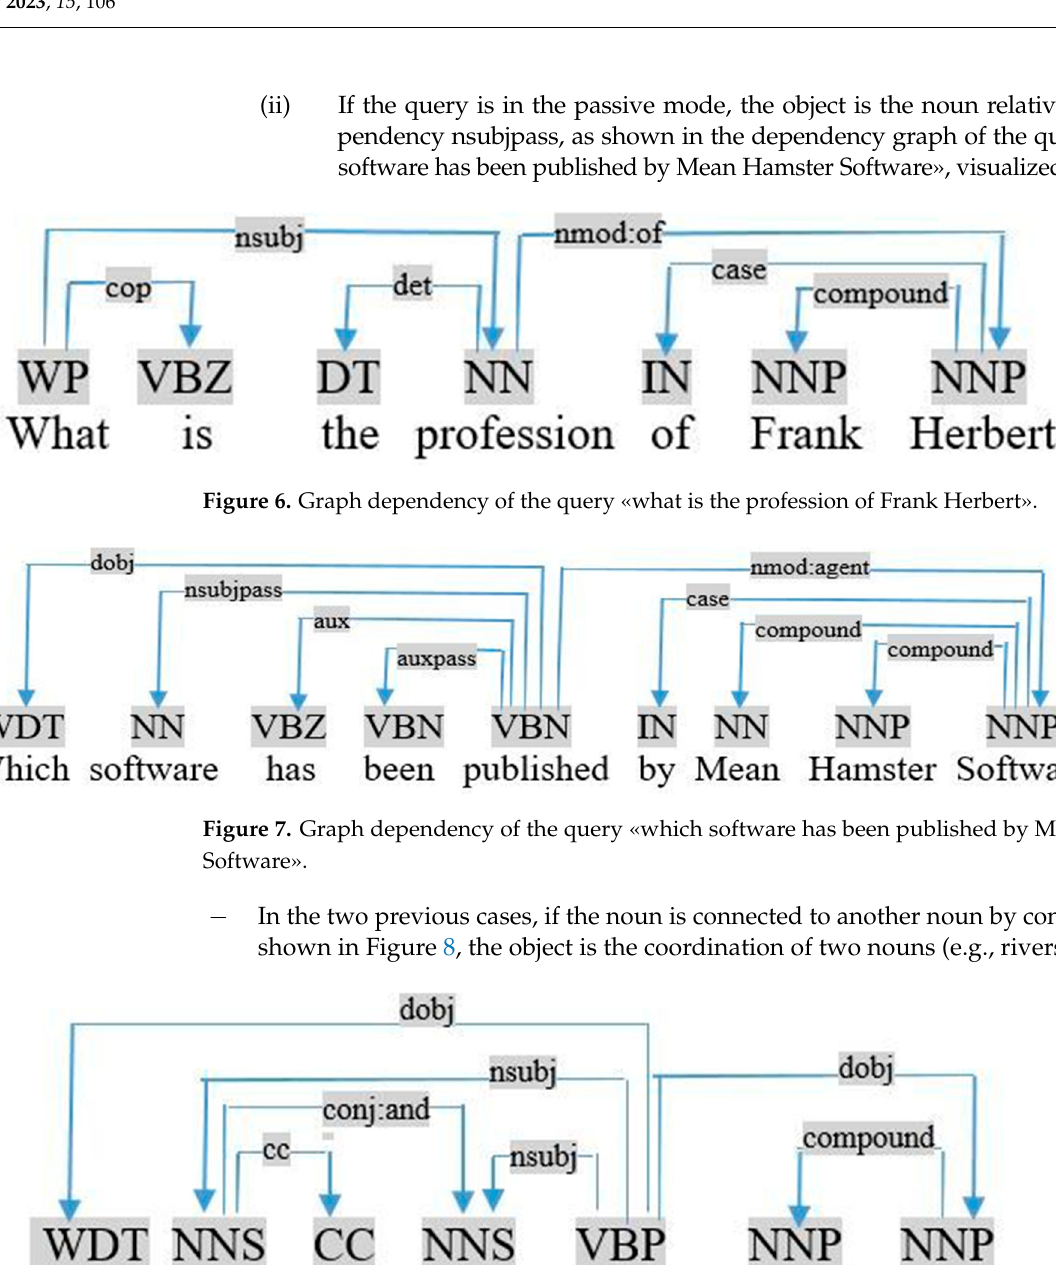
Figure 8. Graph dependency of the query «which rivers and lakes traverse South Carolina».